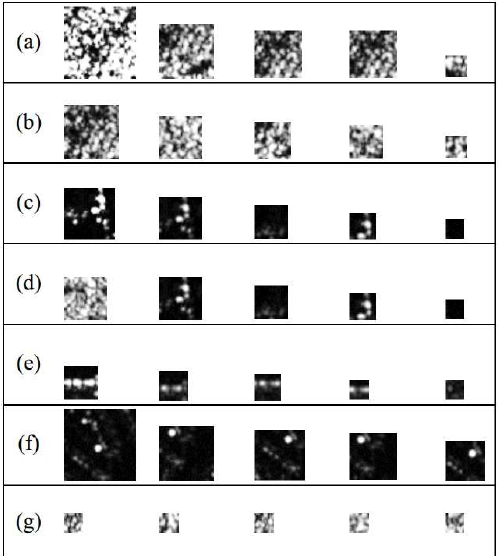
Figure 6. Five detected patches for each category. The detected patches from ( a ) to ( g ) correspond to the categories in Figure 5; those patches among different categories exhibit distinct visual properties,